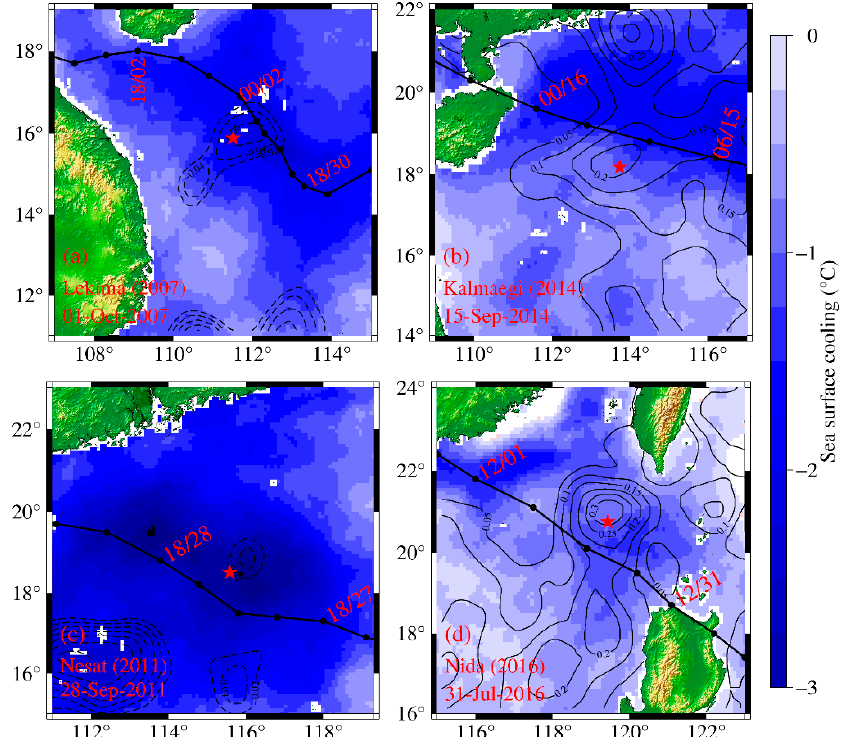
Figure 4. Typical cases of eddies’ impacts on sea surface cooling as typhoons passed over ( a , c ) CEs and ( b , d ) AEs. The top ( a , b ), (bottom, c , d ) two panels show the eddies located to the left (right) of typhoon tracks. The red stars represent the centers of eddies, and the black lines represent the associated tracks of typhoons. The labeled times are the dates when the typhoon was closest to the eddy center. The time labels “HH/DD” present the dates of corresponding typhoon snapshots during passage.